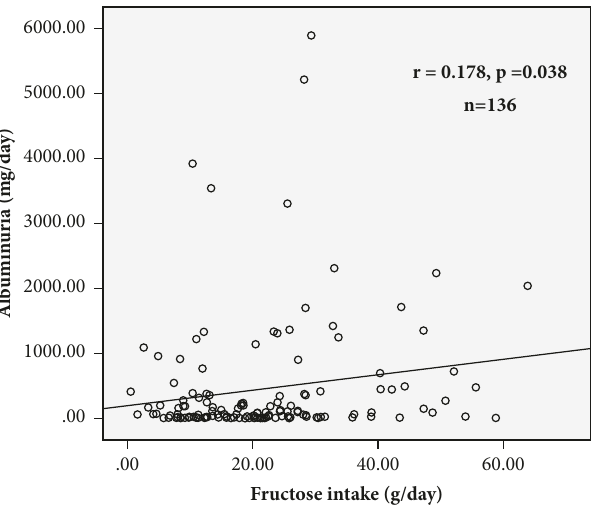
Figure2:Associationbetweenfructoseintake(g/day)andalbumin- uria (mg/day), obtained by Spearman correlation test